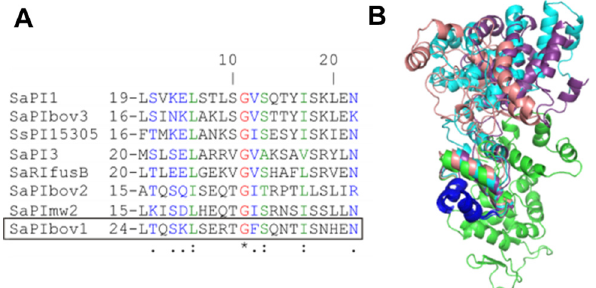
Fig 5. (A) Sequence alignment for the HTH segments of Stl-like repressors. Identical residues are in red ( * ), strongly similar (:) residues are in green, weakly similar residues are in blue (.). The protein investigated in the current study, termed as Stl throughput the text, is boxed (it is equivalent to the repressor of the SaPIbov1 pathogenicity island). (B) Superimpositioned structural models of representative Stl-like repressors from different SaPIs. Proteins are in cartoon representation. SaPIbov1 Stl is cyan, Stl-like repressors of SaPIbov3, SaPI1, and SsPI15305 pathogenicity islands are violetpurple, salmon, and green, respectively. Predicted HTH motifs of all proteins are colored dark blue. Stereo view of these structures is shown in S14